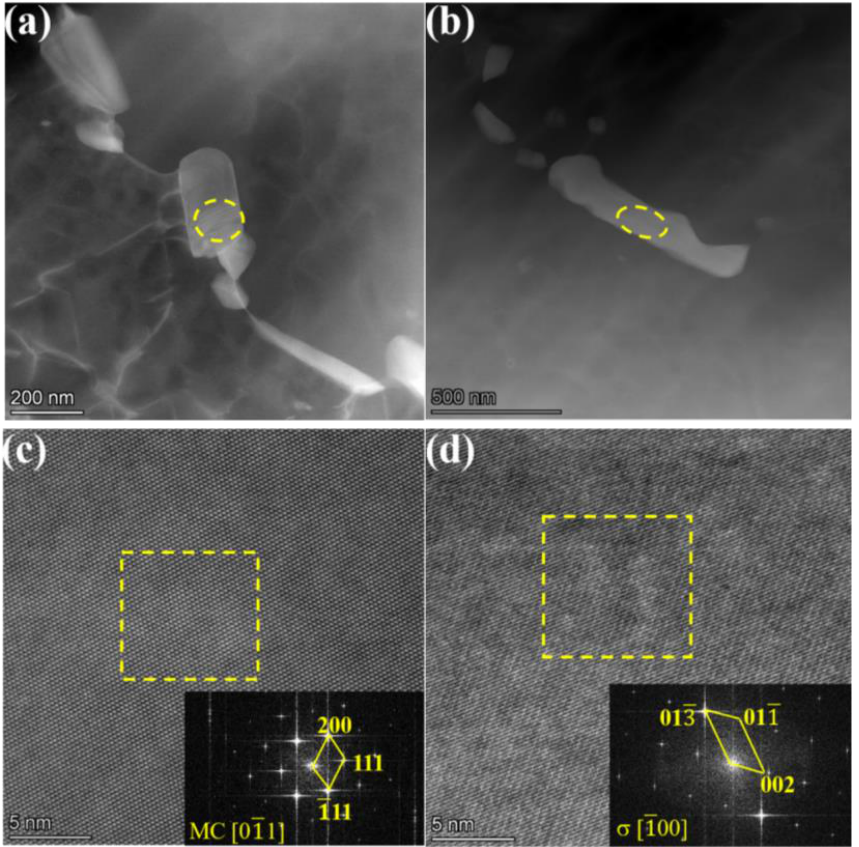
Figure 8. TEM investigation of the precipitates formed in the 13Co alloy. ( a ) HAADF-STEM image of MC carbides; ( b ) HAADF-STEM image of the σ phase; ( c ) HAADF-HRSTEM image and the corresponding FFT pattern of the MC carbide; ( d ) HAADF-HRSTEM image and the corresponding FFT pattern of the σ